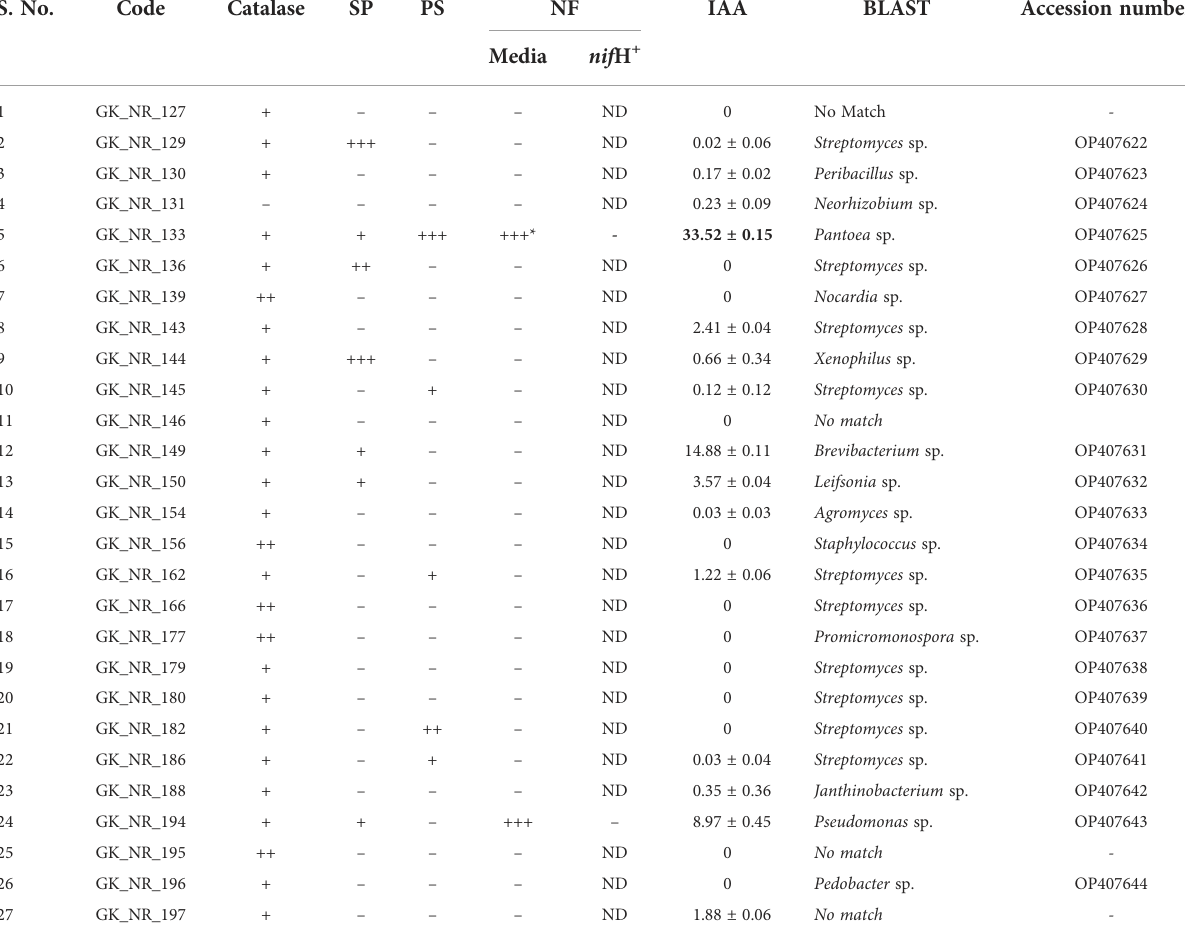
TABLE 1 Bacterial characterization of the isolates from the rhizosphere of snowbrush ceanothus from the native region based on catalase production, siderophore, phosphate solubilization, nitrogen fi xation, and IAA production. S.